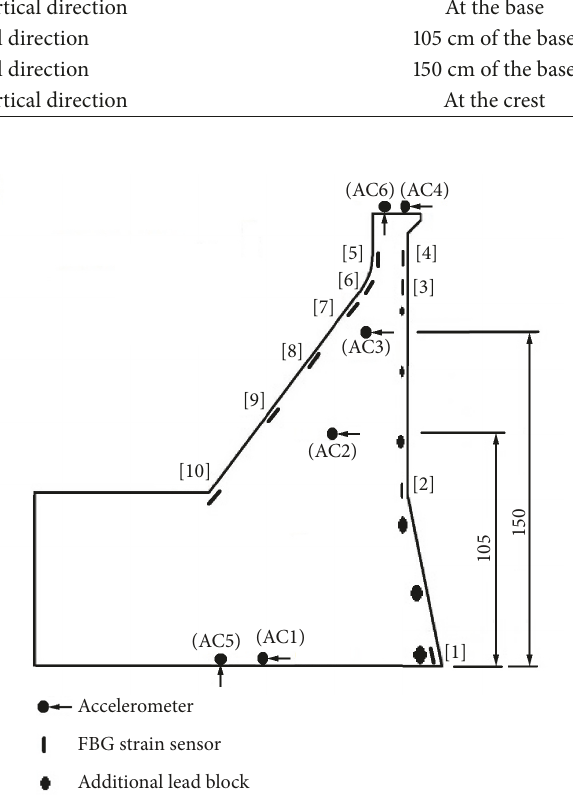
Figure 8: Arrangement of strain gauges for the